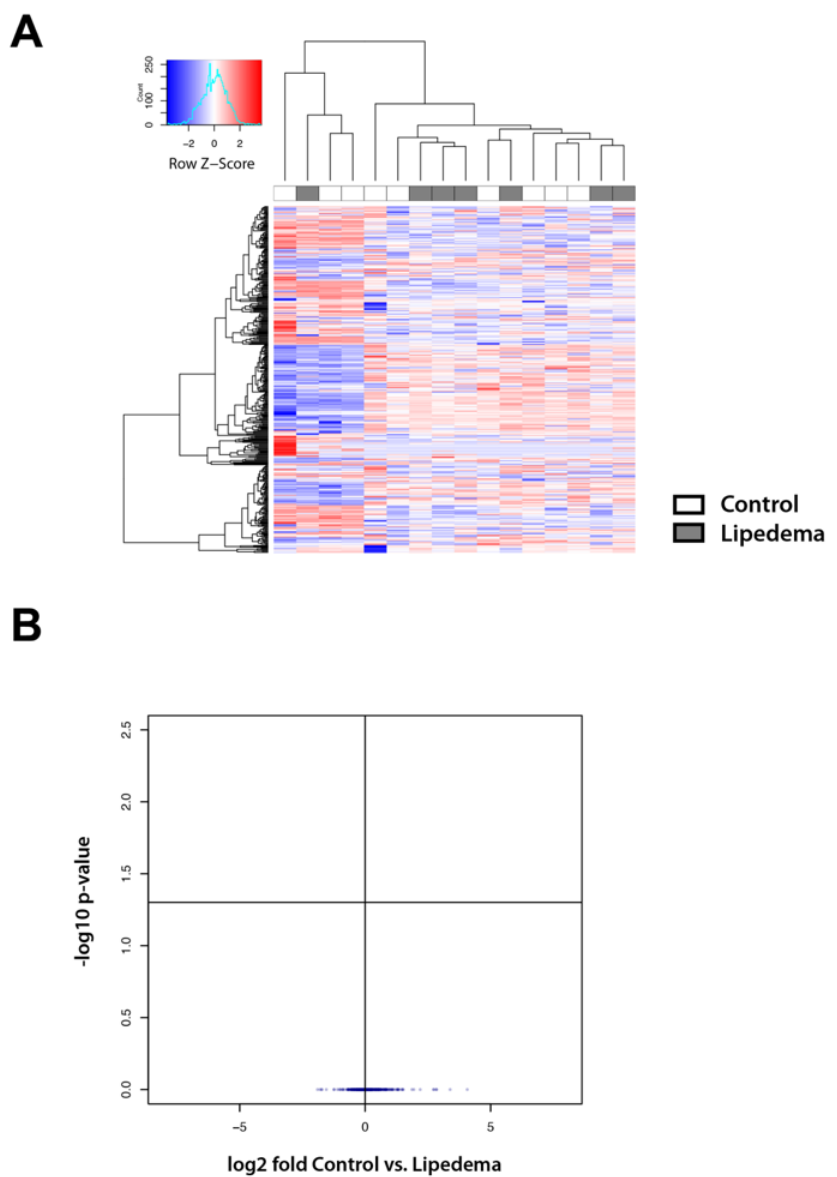
Figure 2. Lipid mass spectrometry analysis reveals a comparable lipid composition in the tissue of lipedema versus control patients ( A ) Lipidomic heat map showing log2 fold change of molecular lipid species comparing tissue of lipedema versus control patients using unsupervised hierarchical clustering. Each horizontal row represents a molecular lipid and each vertical column represents a tissue sample. Relative change of each lipid is indicated by coloring, and the scale is represented in the color key. ( B ) Volcano plot showing no statistically significant alterations in the lipid composition between the disease and the control groups. N (Control): 7 patients and N (Lipedema): 9 patients.